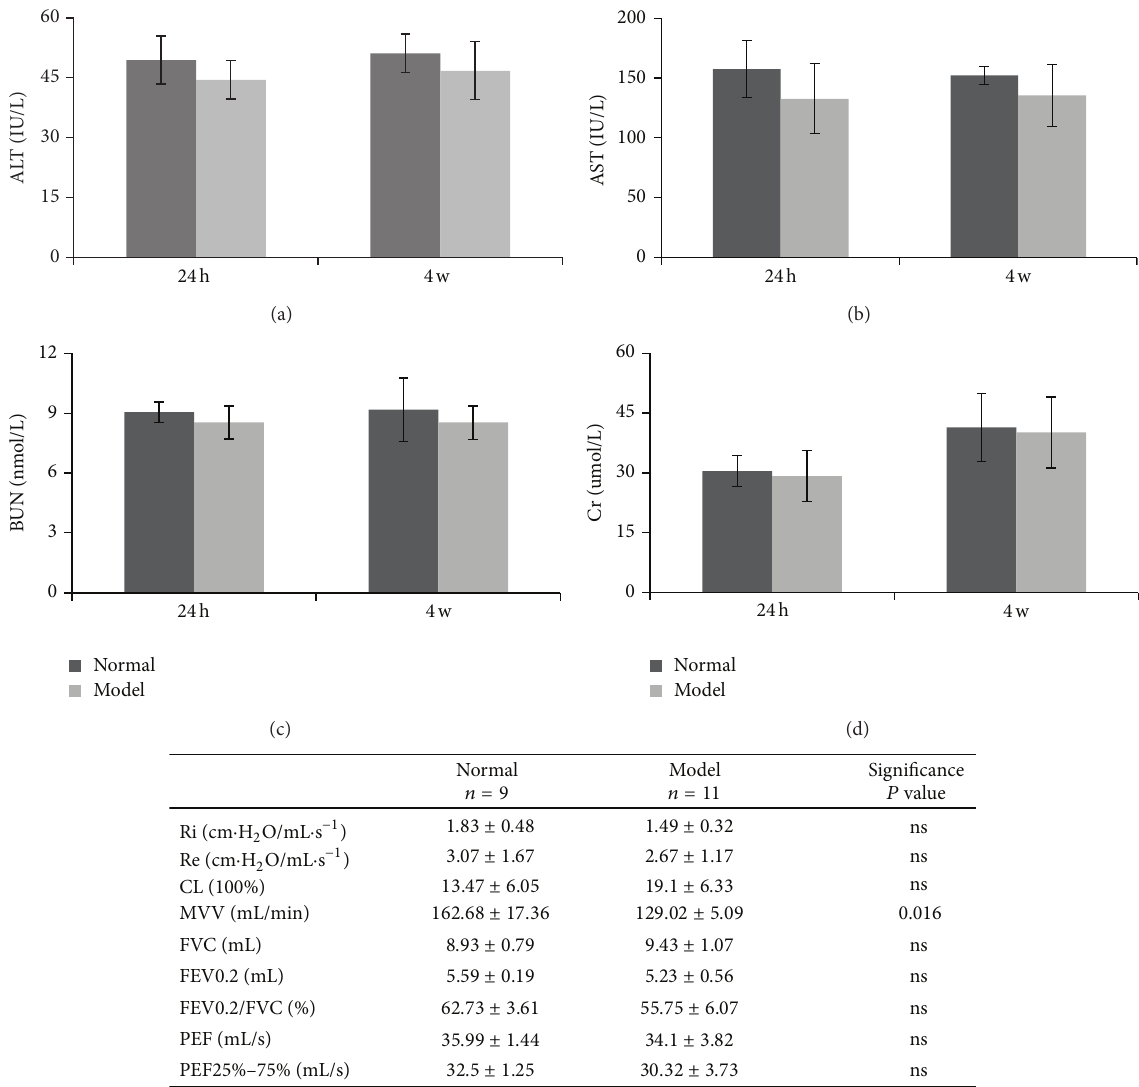
Figure 5: Liver, renal, and pulmonary function results. (a) and (b) Changes in ALT and AST of rat liver after TNBS-ethanol enema. (c) and (d) Changes in BUN, and Cr of rat liver after TNBS-ethanol enema. TNBS-ethanol enema resulted in a slightly decrease but no significant change in serum concentration of ALT, AST, BUN, and Cr when compared with the normal both in 24 hours and 4 weeks ( 𝑃 > 0.05 ). (e) Results of pulmonary function tests after TNBS-ethanol enema. Ri: resistance of airways at inspiration; Re: resistance of airways at expiration; CL: lung compliance; MVV: maximal voluntary ventilation; FVC: forced vital capacity; FEV0.2: forced expiratory volume in 0.2 second; FEV0.2/FVC: ration of FEV0.2 and FVC in %; PEF: peak expiratory flow; FEF25%–75%: and forced midexpiratory flow